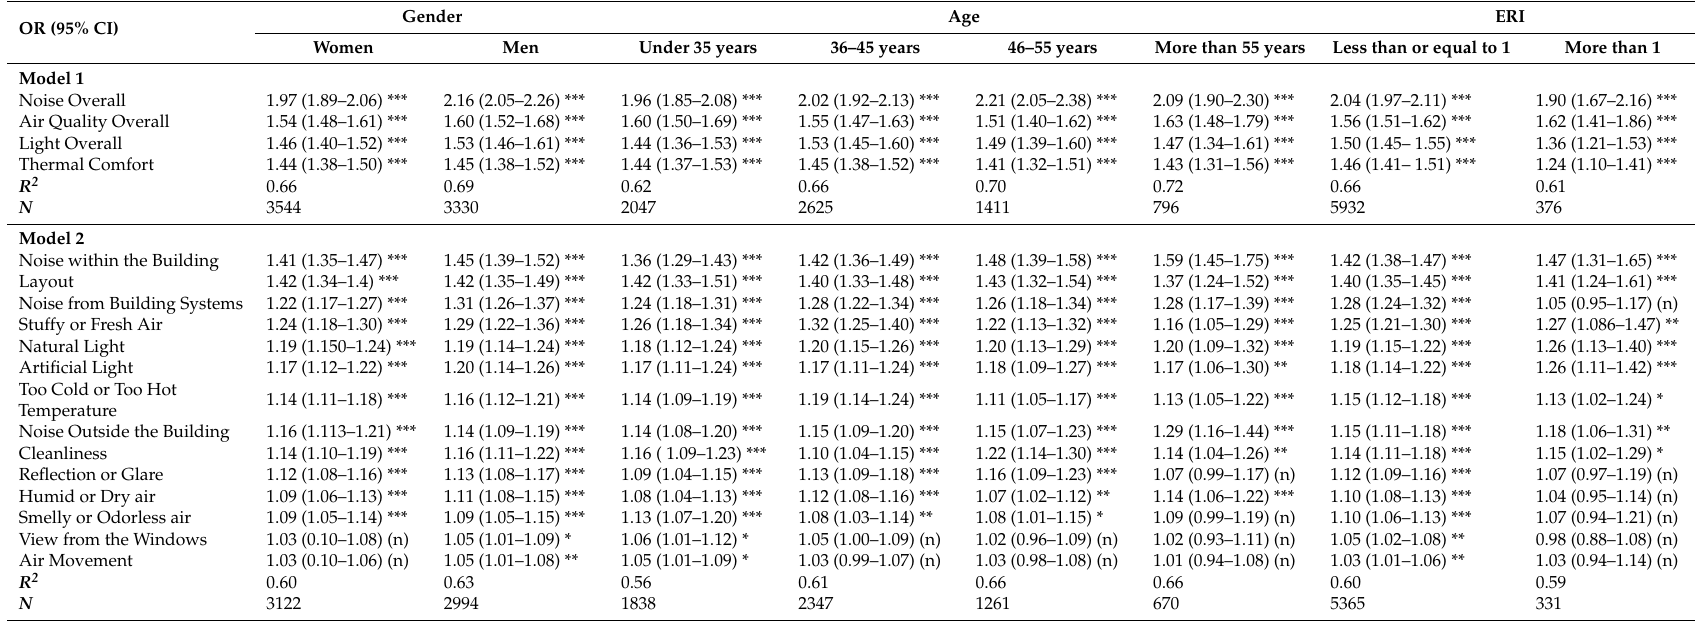
Table 5. Relations between overall comfort and satisfaction with indoor environmental quality (IEQ) (Model 1) and detailed indoor environmental parameters (Model 2) according to individuals’characteristics in OFFICAIR